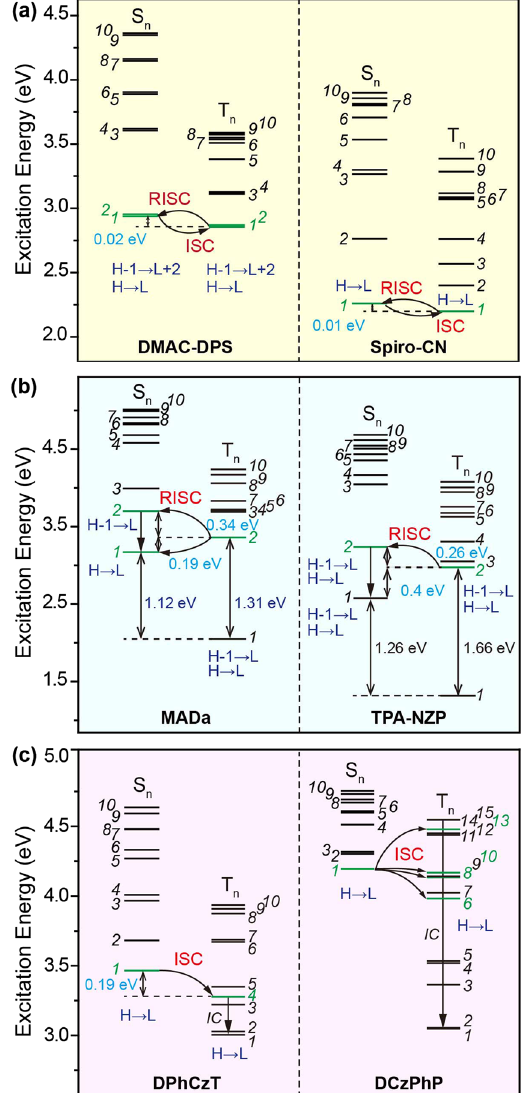
Figure 4. Energy diagrams and transition configurations of singlet (S n ) and triplet (T n ) excited states of ( a ) TADF, ( b ) HLCT and ( c ) OURTP molecules. Feasible excited states for exciton transformation are highlighted in